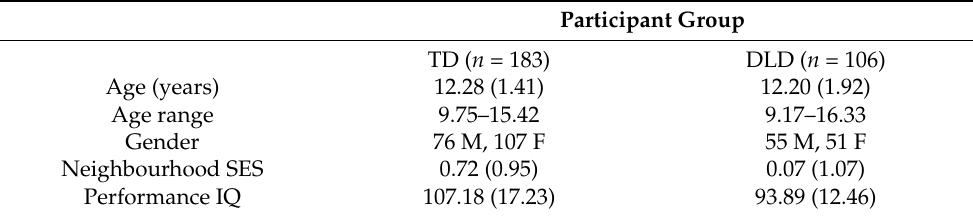
Table 1. Participant